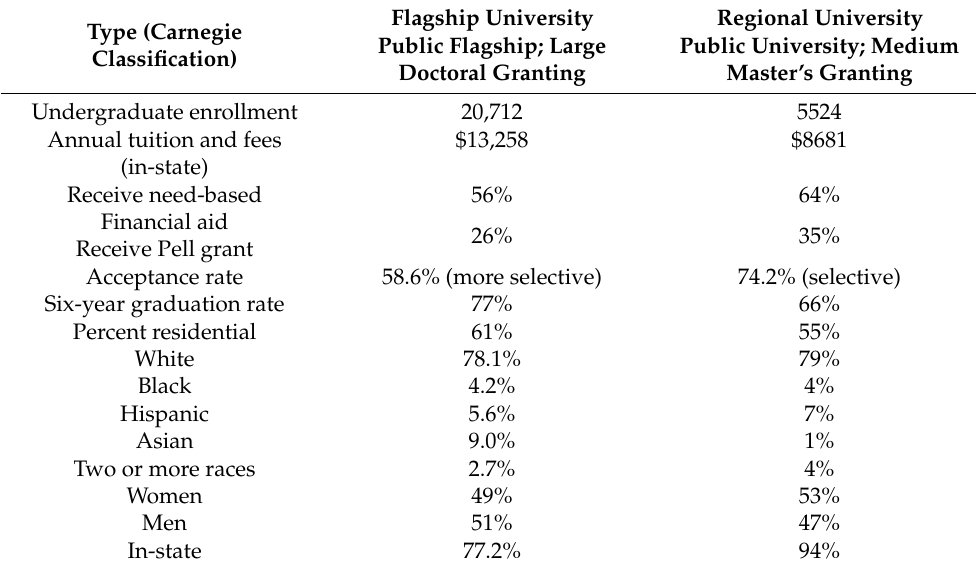
Table A1. Institutional characteristics (AY 16–17 data).